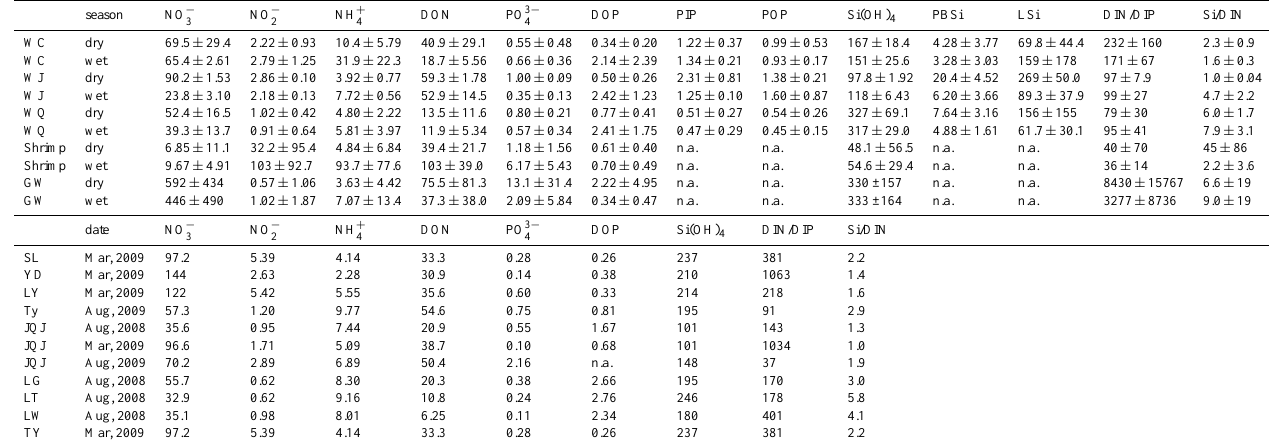
Table 2. Mean ± SD for nutrient concentrations (µmolL − 1 ) and molar ratios in surface water of the Wenchanghe (WC), Wenjiaohe (WJ), Wanquanhe (WQ), shrimp ponds and groundwater (GW), and nutrient concentration (µmolL − 1 ) in other small rivers along the eastern Hainan Island in different seasons during the investigation periods (wet season: May to October; dry season: November to April). LY: Lunyanghe; YD: Yanduihe; SL: Shanlonghe; Ty: Tayanghe; TY: Taiyanghe. n.a.: no